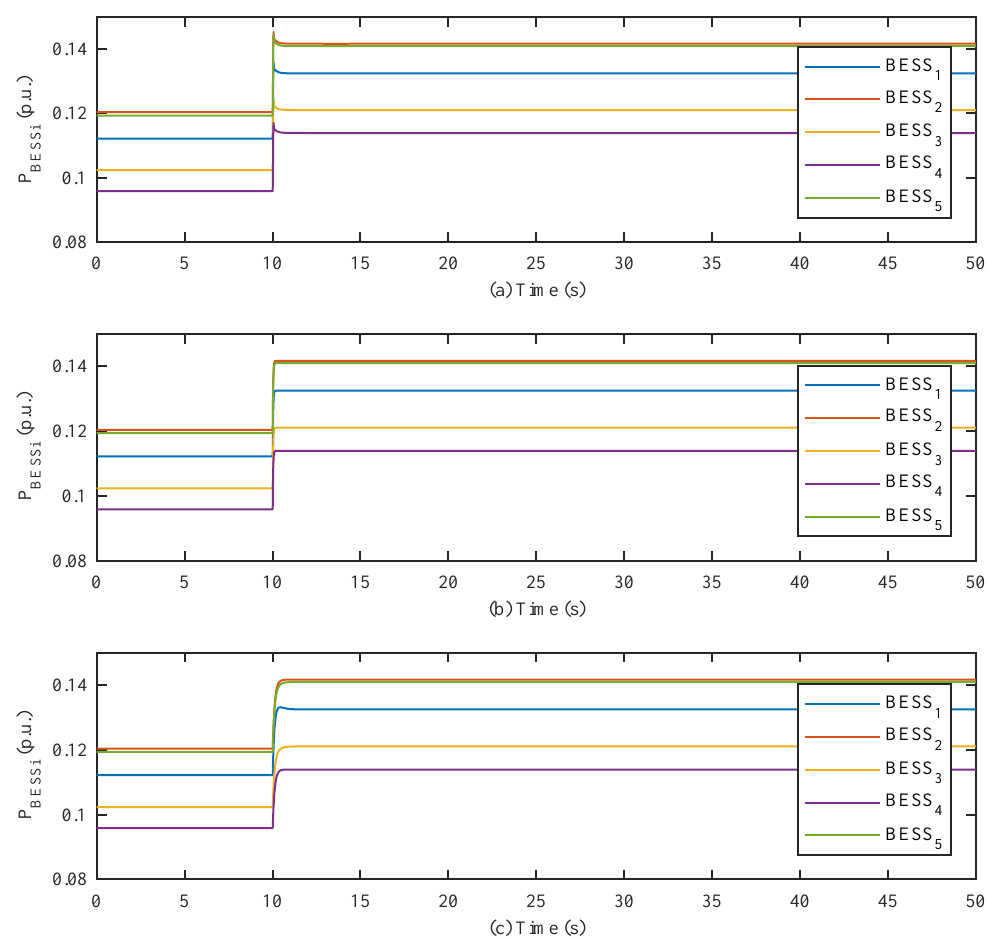
Figure 16. Power of the BESSs. ( a ) Power of the BESSs with the proposed method. ( b ) Power of the BESSs with the method in [16]. ( c ) Power of the BESSs with the method in [14].